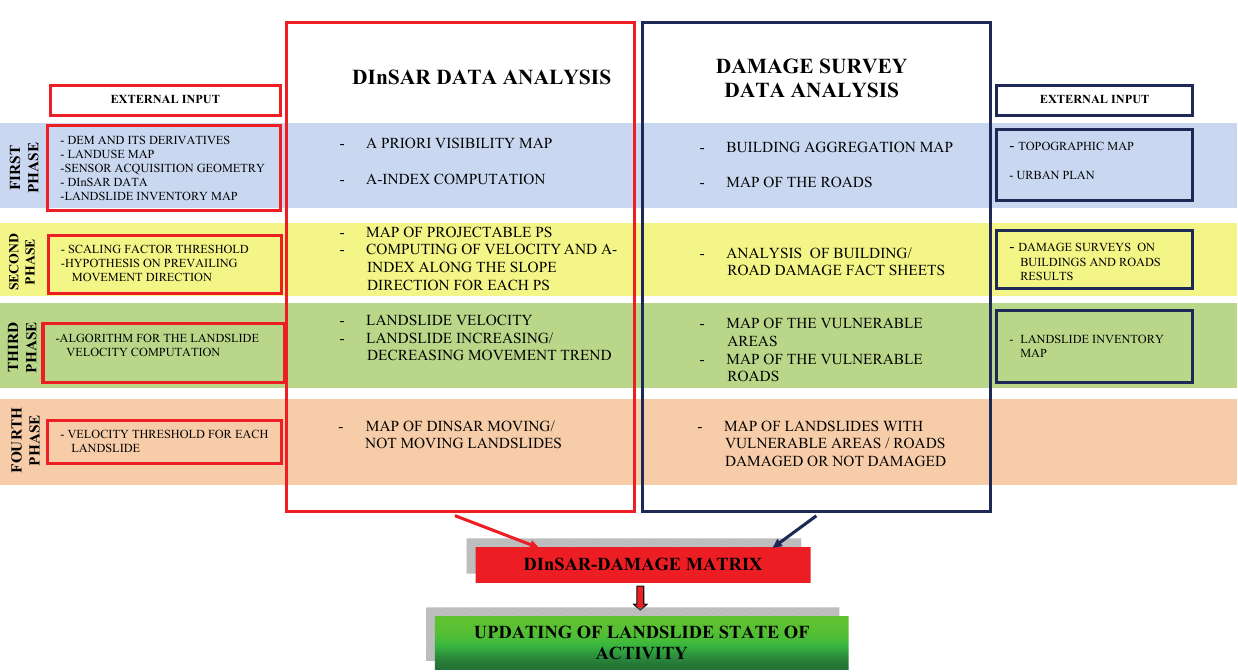
landslide state of activity. In particular, the A-Index repre- sents the second order derivative of the second order polyno- mial curve best fitting the PS displacement time series (see Fig. 7a). The combination of the velocity value and the A- Index of each PS can provide useful information on the trend of measured displacements. In particular, as it is shown in Fig. 7b for a sample dataset, when the signs of the A-Index and the velocity are concordant (i.e. both negative or posi- tive) the trend of the time series can be considered as increas- locity values (i.e. positive and negative) represents decreas- log-scale of the couples velocity A-Index is